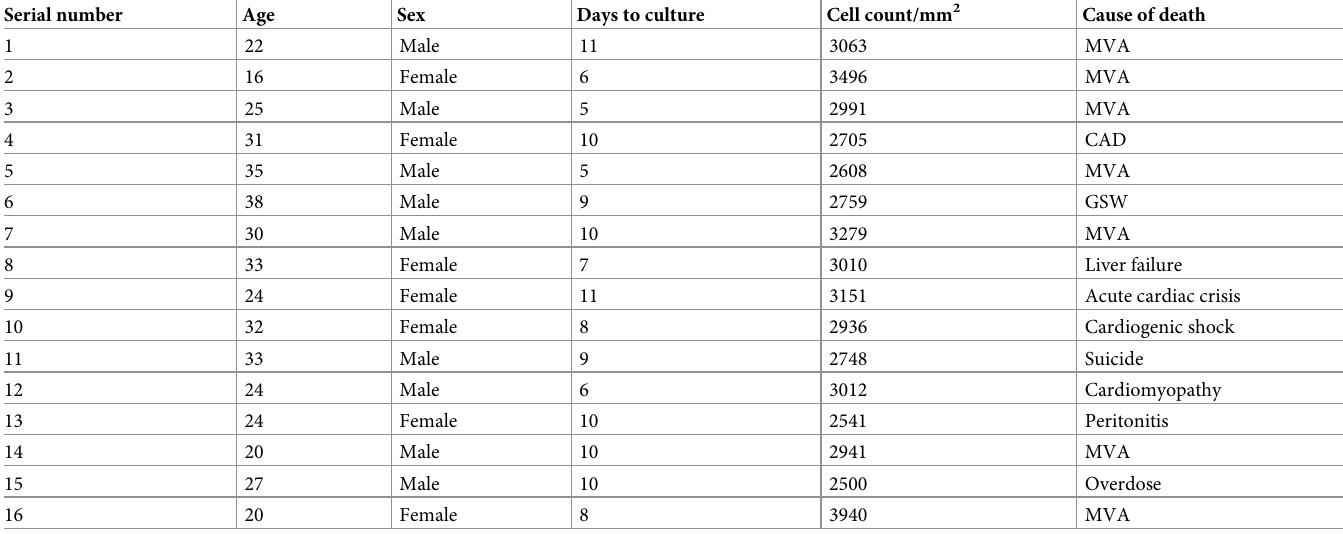
Table 1. Cornea´s donor data, including age, sex, days stored in Optisol until culture, and endothelial cell count.